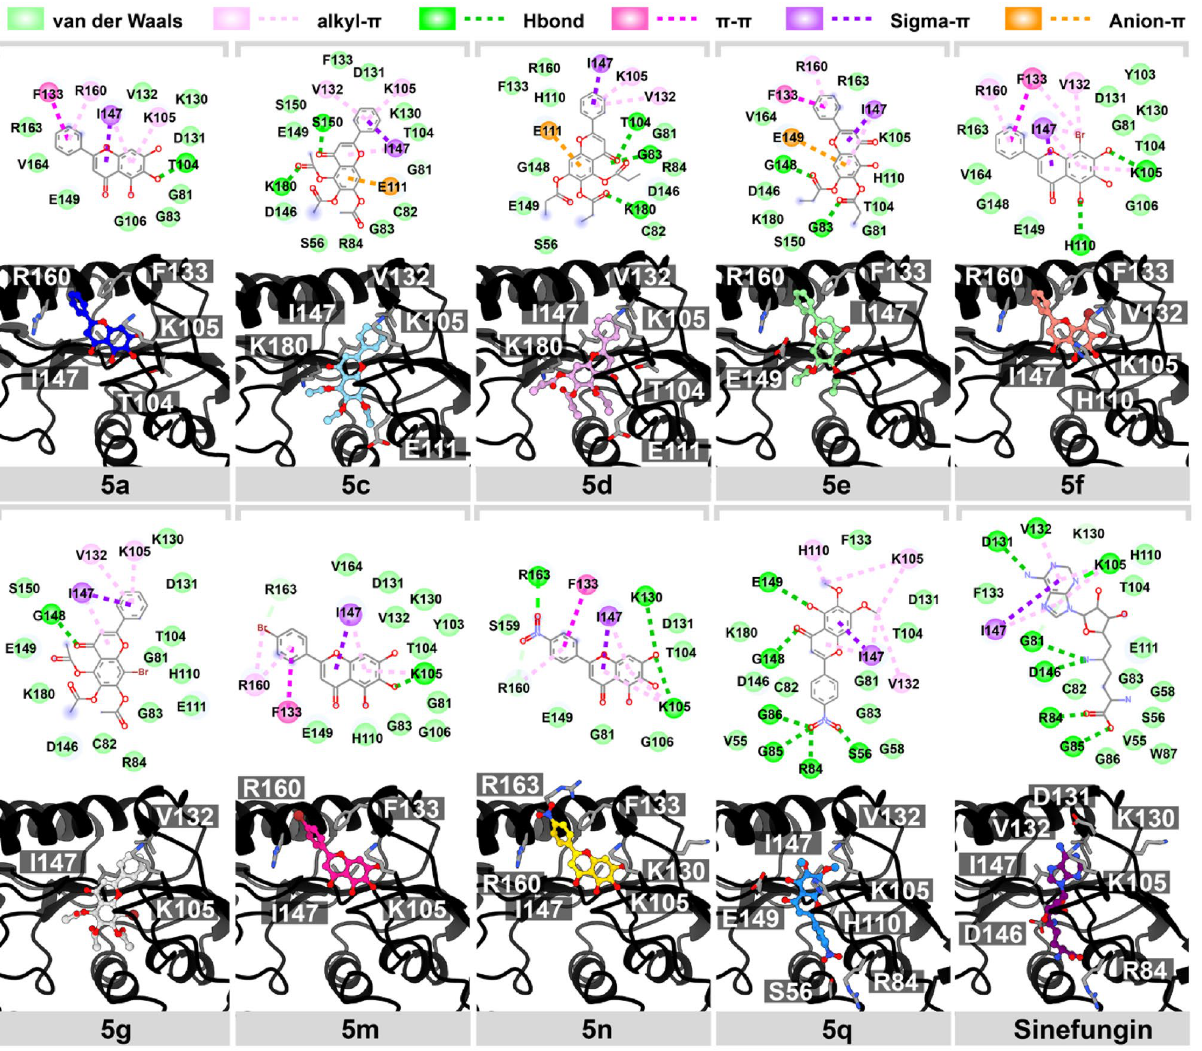
Figure 6. 2D and 3D interaction view of potent flavone analogs and NS5 MTase’s native inhibitor interacting in the SAM binding pocket of NS5